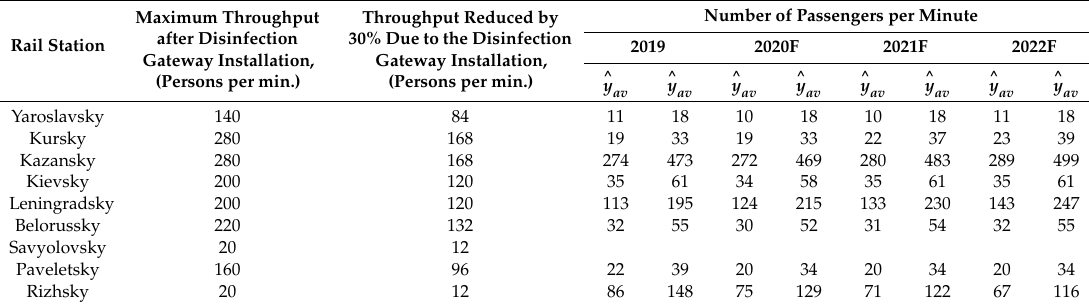
Table 8. The forecast of passenger flow for long-distance rail services until 2022 and throughput of the entry groups, fitted with stationary screening equipment, at the rail stations in the city of Moscow, considering the use of disinfection